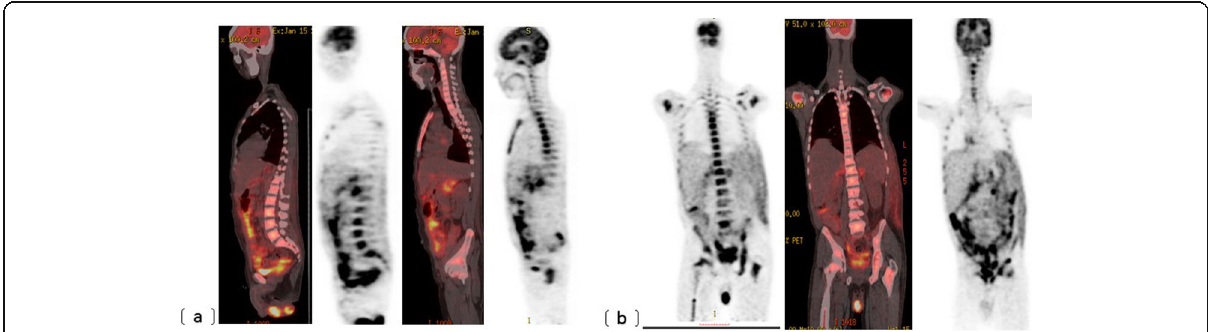
Fig. 7 A 36-year-old male patient, pathologically proven DLBCL ( a ) and ( b ) are initial PET images and PET/CT fused images in the sagittal ( a ) and coronal ( b ) planes showing diffuse bone marrow uptake with intestinal, adrenals, omental, peritoneal, and testicular uptake. BMB was